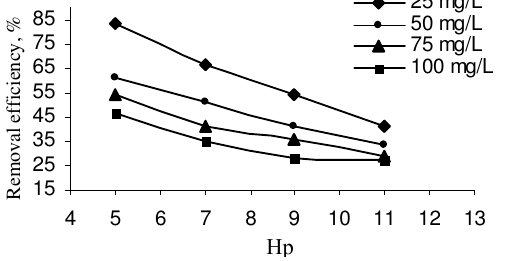
Figure 2. Effect of pH on dye removal in different dye concentration (contact time =1 h, adsorbent dosage=0.8 g)